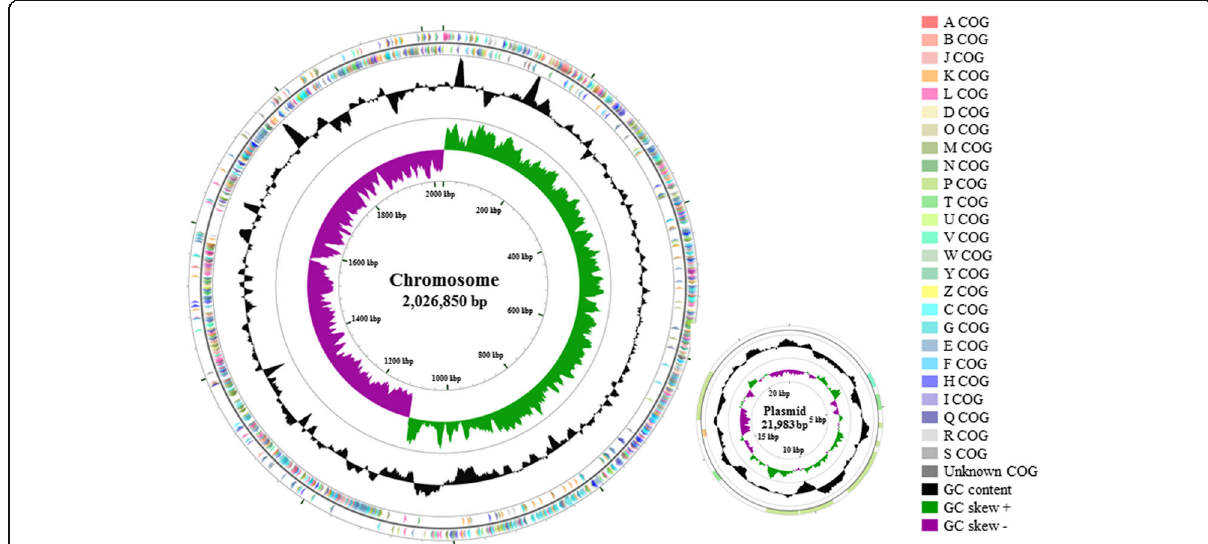
Fig. 3 Graphical maps of the Leuconostoc suionicum DSM 20241 T chromosome and plasmid. The circular maps were set up by the CGView Server [30]. From the outside to the center: Genes on forward strand (colored by COG categories), genes on reverse strand (colored by COG categories), GC content (in black ) and GC skews, where green indicates positive values and magenta indicates negative values